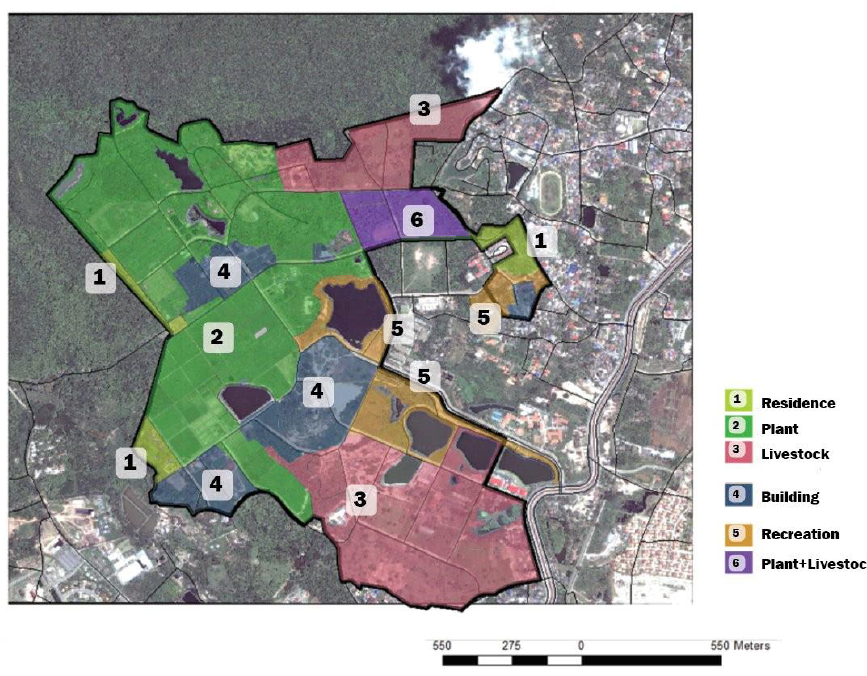
Figure 8. Zoning results of suitability analysis.